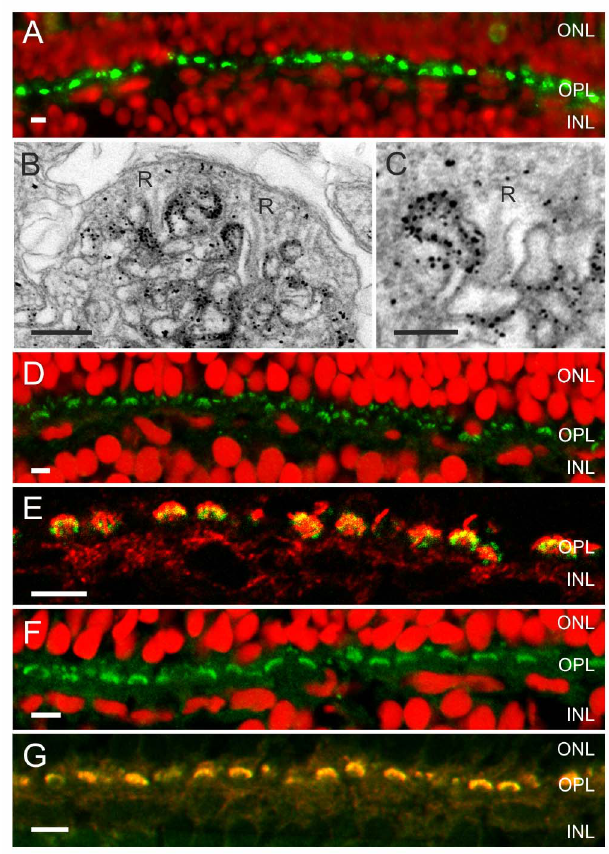
Figure 2. An ATP release mechanism and the enzymes needed to hydrolyze ATP and degrade adenosine are present in the synaptic complex of cones. (A) Fluorescent images of zebrafish retina showing Panx1-IR (green) and a nuclear stain (red) (from Prochnow et al. [11]). Panx1-IR is present in characteristic horseshoe- shaped structures indicative for processes invaginating the cone synaptic terminal. (B) Electronmicrograph of a cone synaptic terminal in zebrafish retina. Immunolabeling is restricted to HC dendrites flanking the synaptic ribbons (R). (C) Higher magnification of a HC dendrite lateral of the synaptic ribbon (R). Note that one HC dendrite is devoid of Panx1 labeling. (D) NTPDase1-IR (green) and a nuclear stain (red). NTPDase1-IR is also present in horseshoe-shaped structures characteristic for localization in HC dendrites. (E) Double labeling of NTPDase1 antibody with an antibody against GluR2 (green), a marker for HC dendrites [63,64], indicated that NTPDase-1 (red) was specifically expressed on HC dendrites. (F) ADA-IR (green) was present in horseshoe-shaped structures. (G) ADA-IR colocalized with the GluR2-IR (green), indicating that ADA (red) is expressed on HC dendrites. Expression of ecto-ATPases in the photoreceptor synaptic terminal has been observed previously in rat [39], mouse, and zebrafish [61]. Scale bars in panels A, D, E, F, and G indicate 5 m m. Scale bar in panels B and C indicate 500 nm and 250 nm,